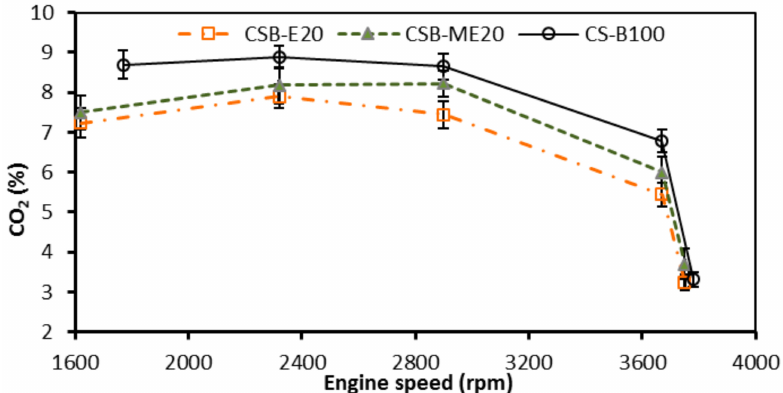
Figure 13. The relationship between engine speeds (rpm) and CO 2 (%) for CS-B100, CSB-E20 and CSB-ME20.